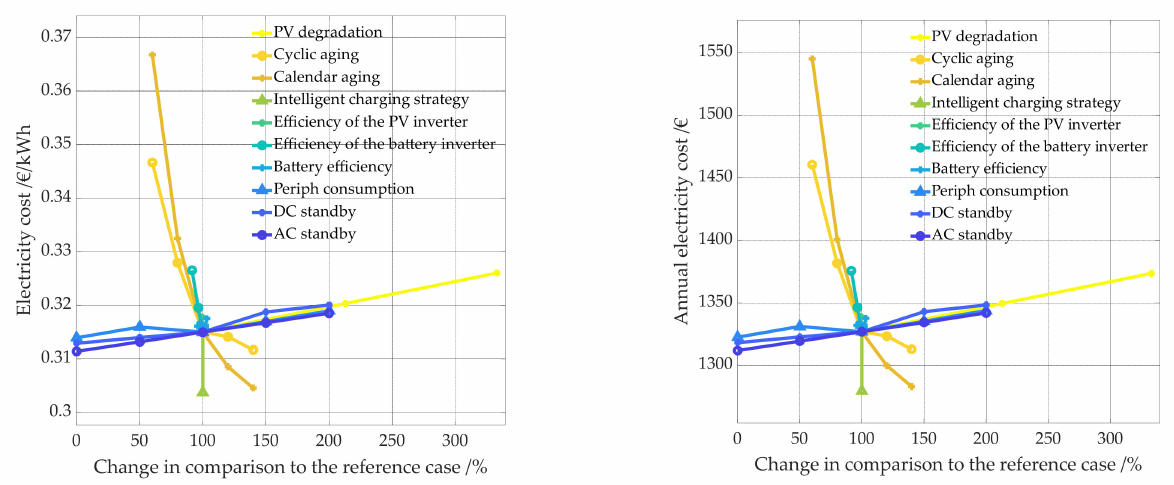
Figure 27. Change of energy costs depending on the change of different technical parameters. The selected PV system and battery combination is the combination that is the most favorable for the respective boundary conditions. The left window shows the costs in € /kWh and the right one shows the annual electricity costs.